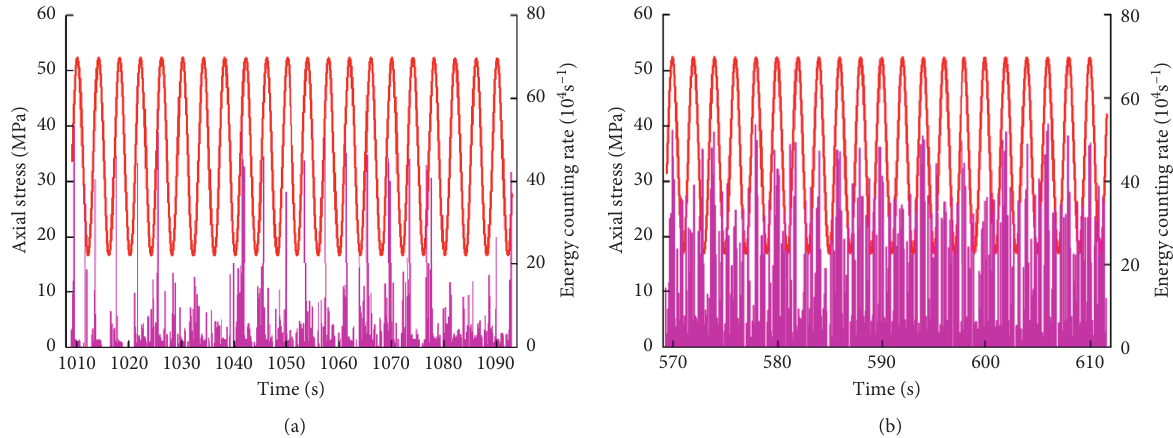
Figure 10: Acoustic emission energy counting rate under the same confining pressure and stress level and different cyclic loading frequency. (a) MB-3, 0.25 Hz and (b) MB-4, 0.5